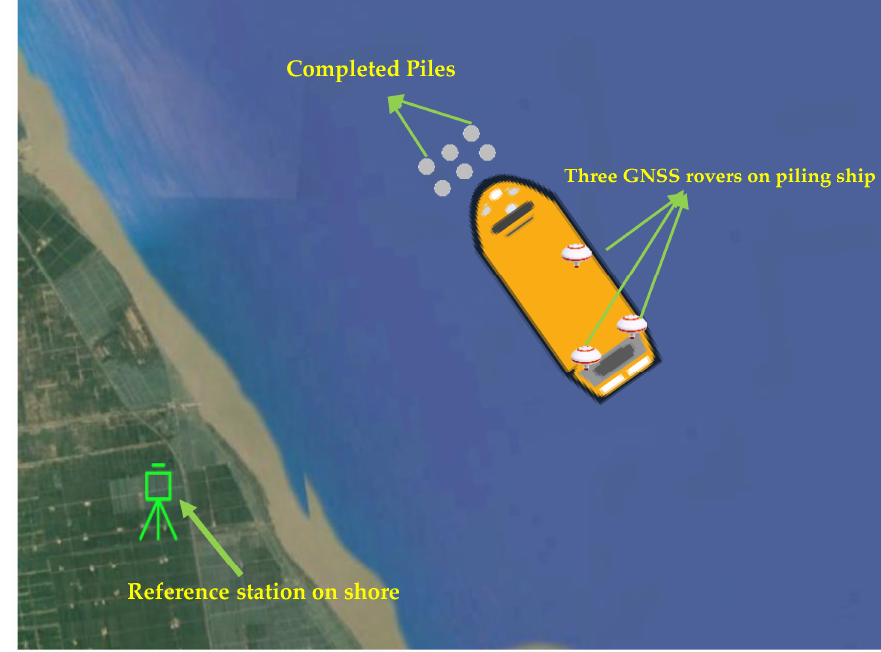
Figure 3. GNSS RTK (Real Time Kinematic) positioning technology for piling foundation project diagram.